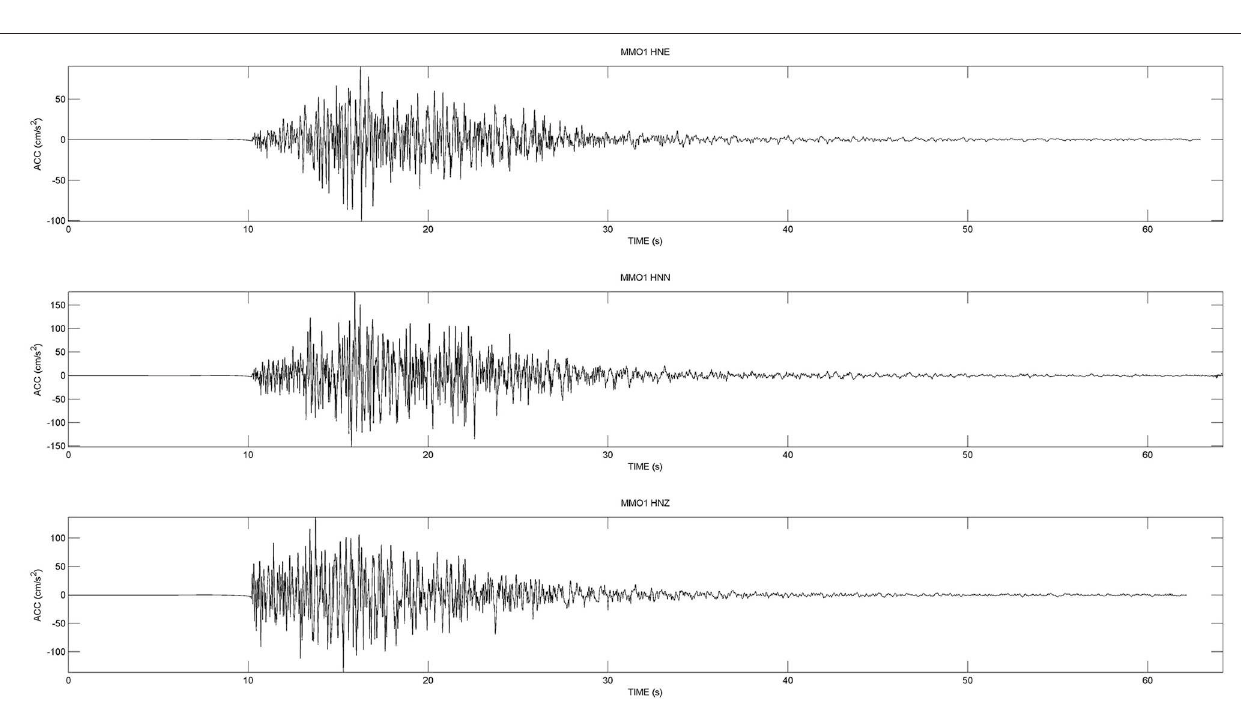
Frontiers in Built Environment |